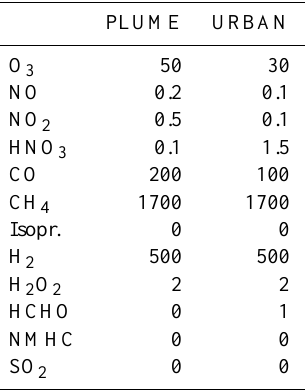
Table 2. Initial mixing ratios for the gas-phase constituents (ppb) of scenarios described by Poppe et al. (2001). NMHC denotes non- methane hydrocarbons.